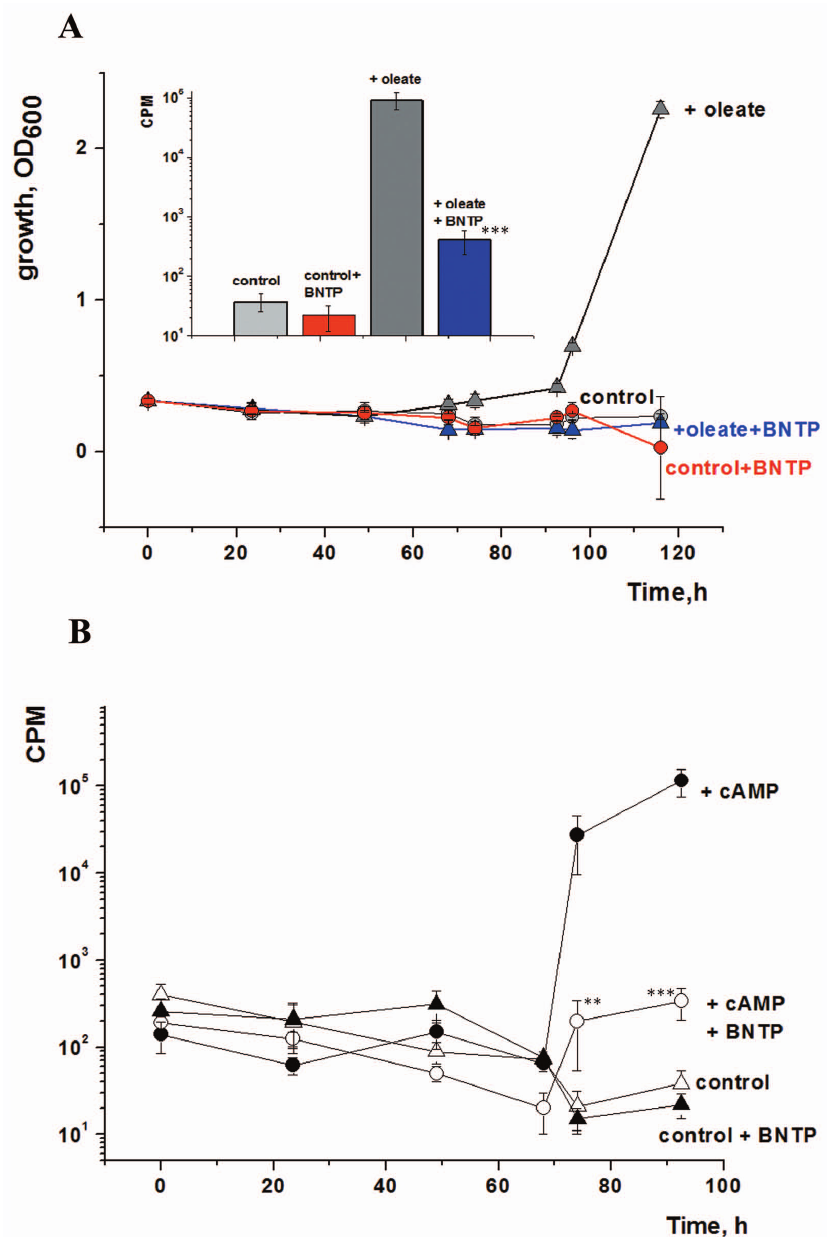
Figure 8. Oleic acid-mediated resuscitation of M.smegmatis NC cells is Rpf-dependent. NC cells were resuscitated in batch mode in the presence and the absence of both oleic acid (3.5 m M) (A) or cAMP (3.0 mM) (B) and the Rpf inhibitor, BNPT (1 m g/ml) in all four possible combinations. BNPT was added at zero time and again after 48 h of incubation. Samples were withdrawn periodically for OD 600 determination (A) and estimation of metabolic activity using 3 H-uracil incorporation (B) The insert to part A shows the level of uracil incorporation in the four cultures measured after 92 h of incubation. The error bars represent the standard error of the mean. Asterisks indicate significance between 3 H-uracil incorporation by cells incubated in the presence of oleate vs both oleate and BNTP (A, insert) or in the presence of cAMP vs both cAMP and BNTP (B) by Student’s